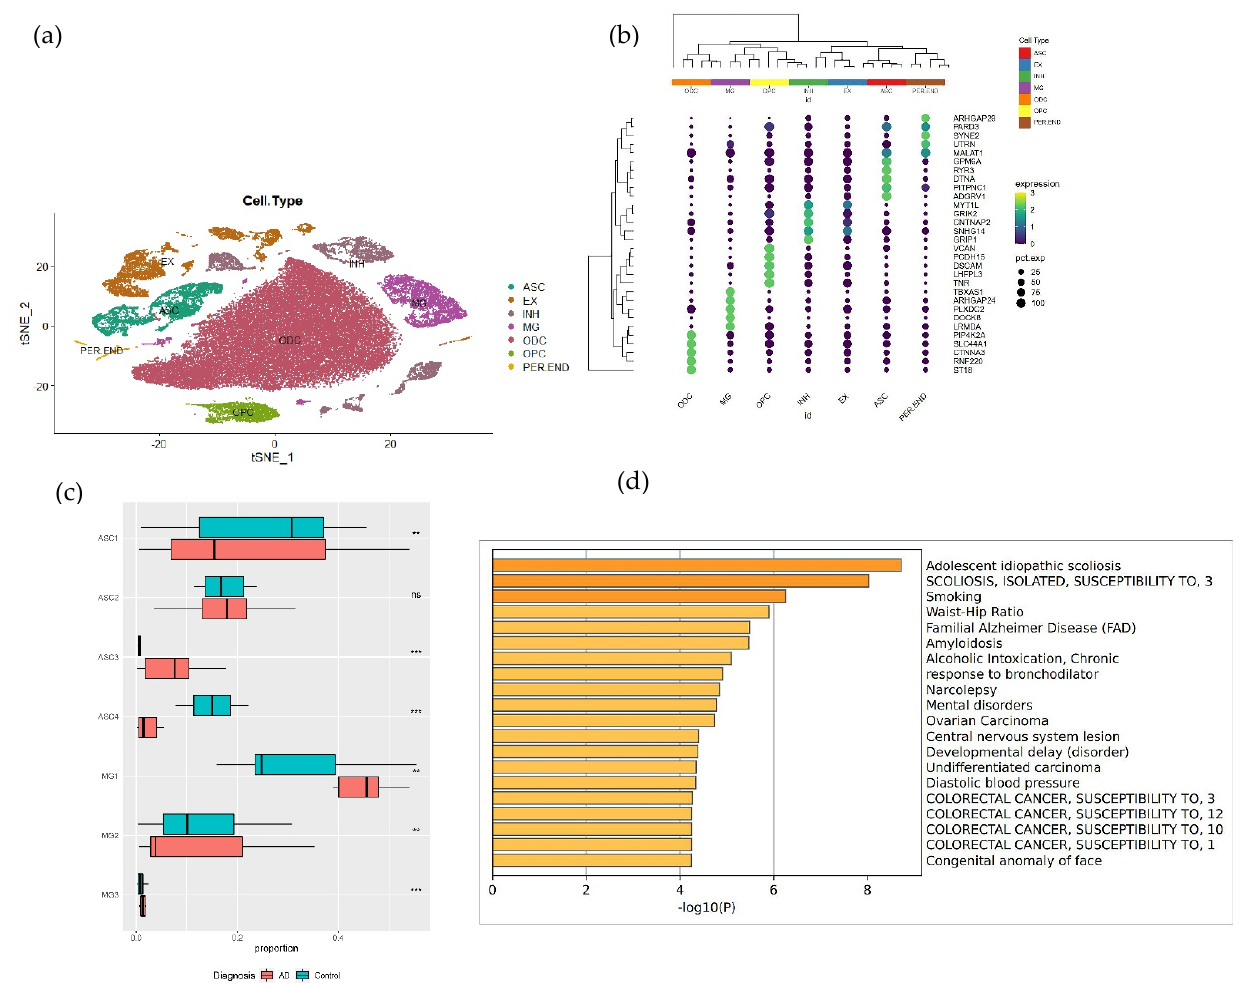
Figure 2. Display of cell types, marker genes, and the extraction of MG1. ( a ) TSNE plot showing 60, 137 cells, mainly for 7 cell types to color. ( b ) Cell type marker gene bubble plot, the size of the bubbles indicates the proportion of genes, from black to yellow indicates low to high gene expression. ( c ) Box plot showed the proportion of each cell cluster and was split by the control and AD samples (“**” represents a p -value of <0.05, “***” represents a p -value of <0.005, “ns” represents a p -value of >0.05). ( d ) DO enrichment analysis of MG1 cluster with − log( p ) values on the horizontal axis and the pathway list on the vertical axis.